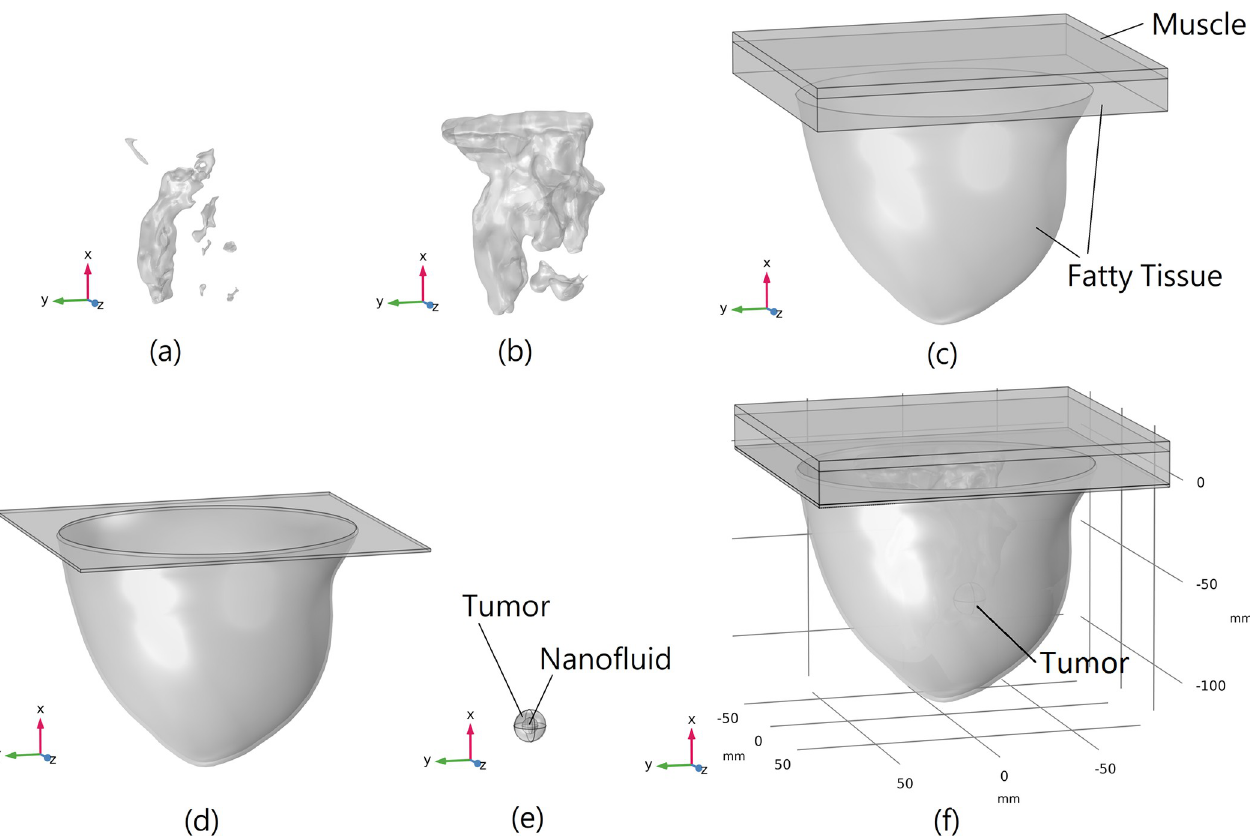
Fig 4. 3D geometry of different tissue types separately and all together, (a) FCG tissue, (b) transitional tissue, (c) fatty tissue and muscle, (d) skin, (e) tumor and injected nanofluid, and (f) all of the tissues inside of each other as the ARBP.